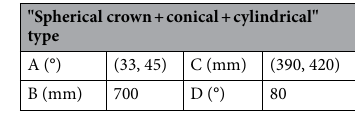
Table 4. Basic parameter setting.